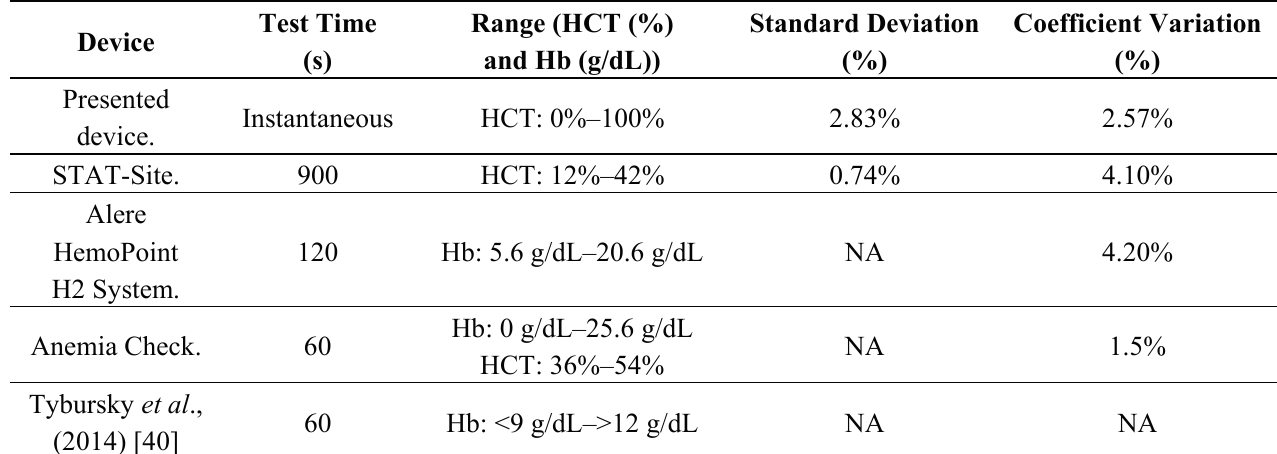
Table 3. Comparison table with different commercial and published anemia PoC diagnostic test.